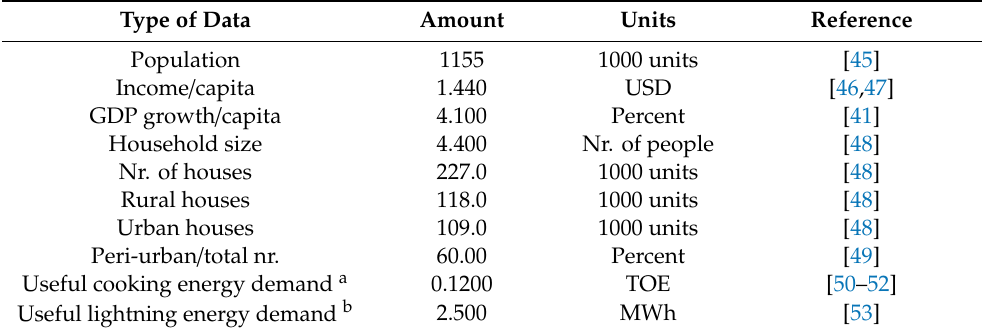
Table 1. Demographic and energy data of Kisumu County for the baseline year 2015 used by Carvalho et al. [26] to generate the LEAP data to the LCA model